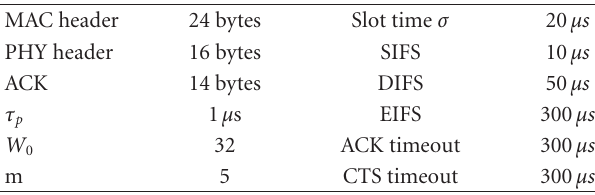
Table 1: Typical network